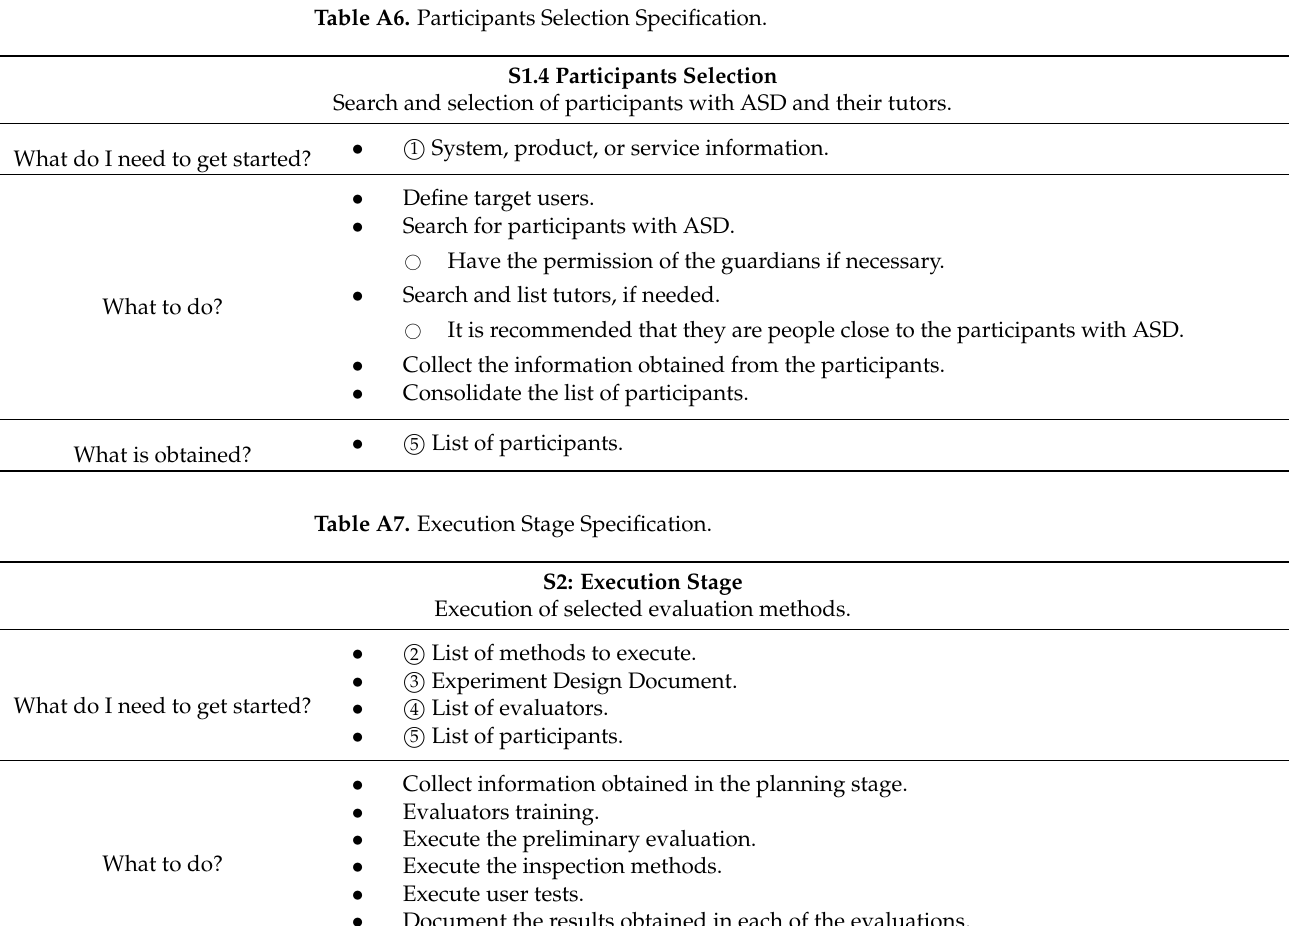
Table A6. Participants Selection Specification.